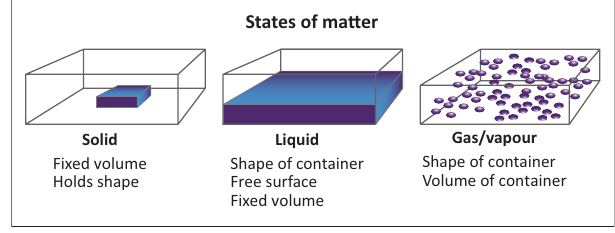
FIGURE 1: States of